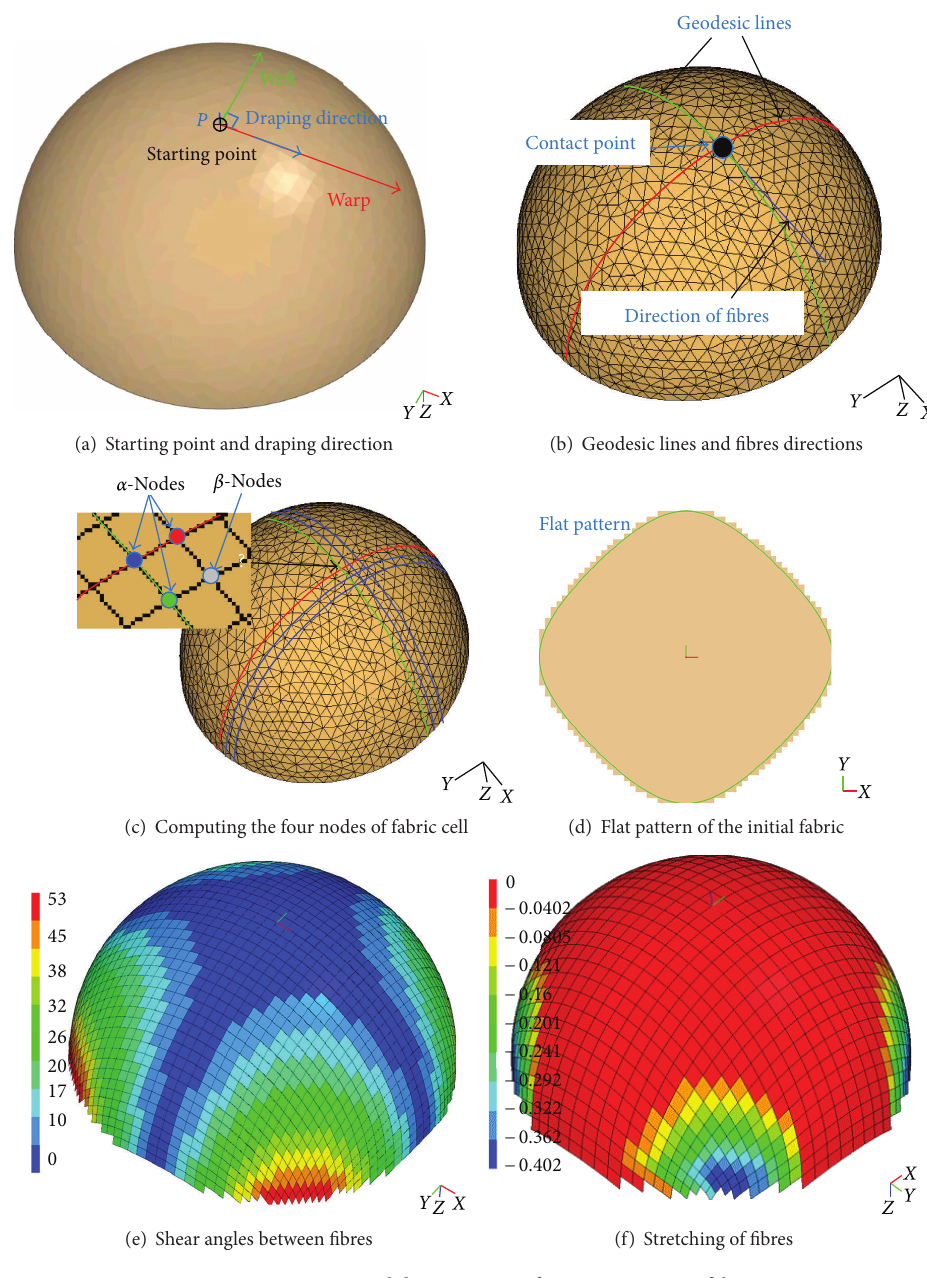
F 2: Geometrical draping steps of woven composite